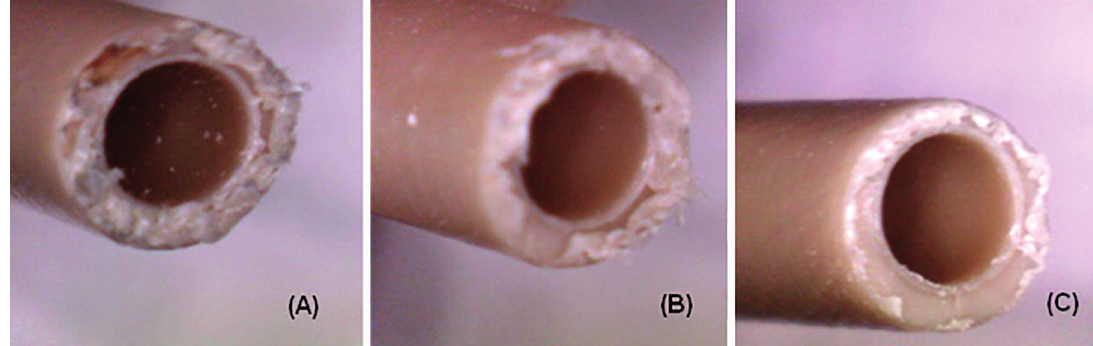
Table 1: Weight loss in mg for PEEKc and PEEKm after machining, hygienization and sterilization process stages by TGA at 10°C ∙ min -1 heating rate.